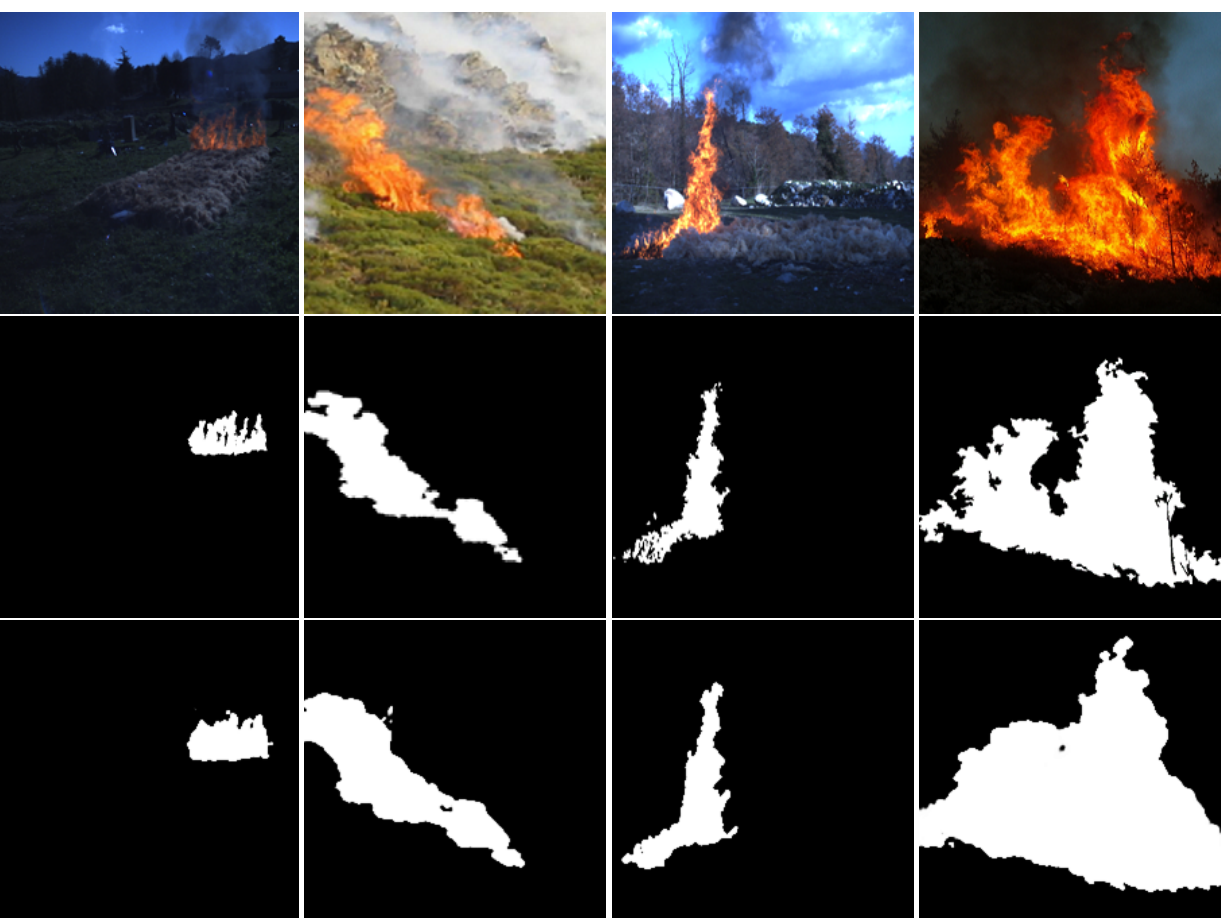
Figure 10. Results of U 2 -Net. From ( top ) to ( bottom ): RGB images, their corresponding mask, and the predicted images of U 2